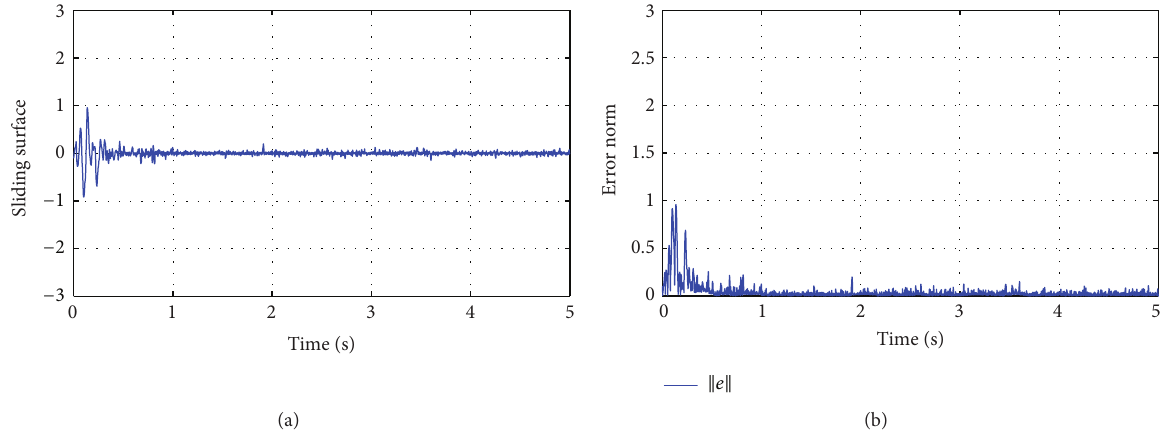
Figure 5: (a) Sliding surface ( 𝑒 1 ) and (b) Error norm ‖𝑒‖ .